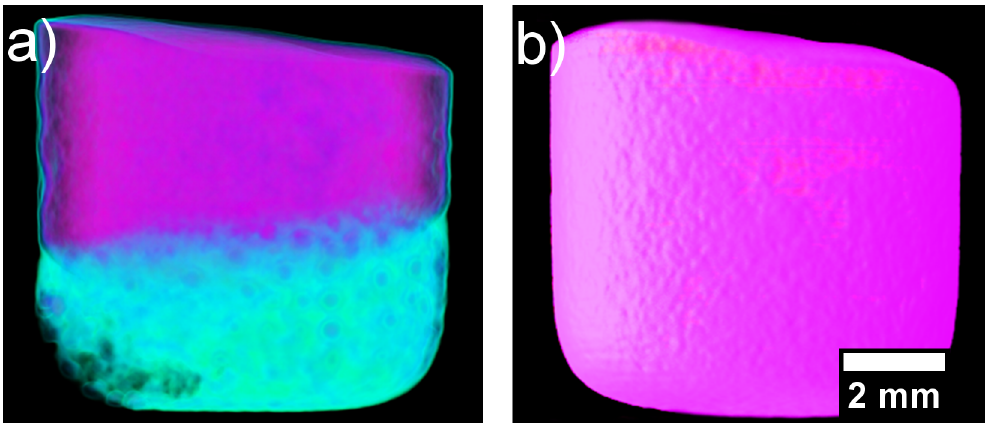
Figure 8. ( a ) Reconstructed computed tomography (CT) of the solidified heterogenous CoCrCu alloy recreated from Ref. [23] with permission from the authors. ( b ) Reconstructed CT of the solidified CoCrCuNi